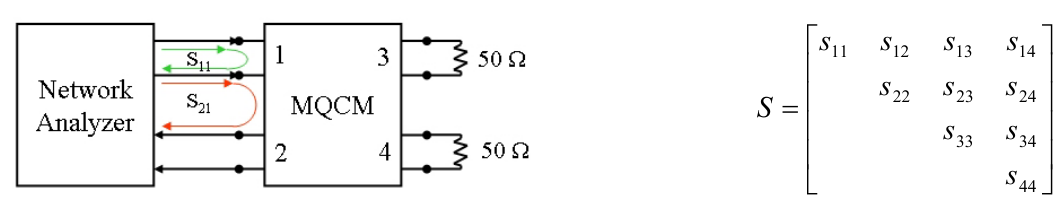
Figure 2. Outline of the scattering coefficients measurements for the MQCM device, represented as a four-ports network (on the left). The scattering matrix (on the right) is characterized by 10 independent parameters, since the matrix is reciprocal (i.e. s